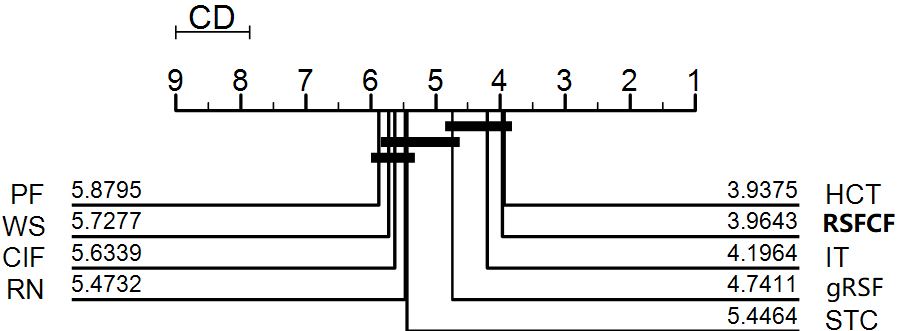
Figure 7. Average ranks and critical differences on accuracy of RSFCF and 7 comparison algorithms over 112 UCR datasets.